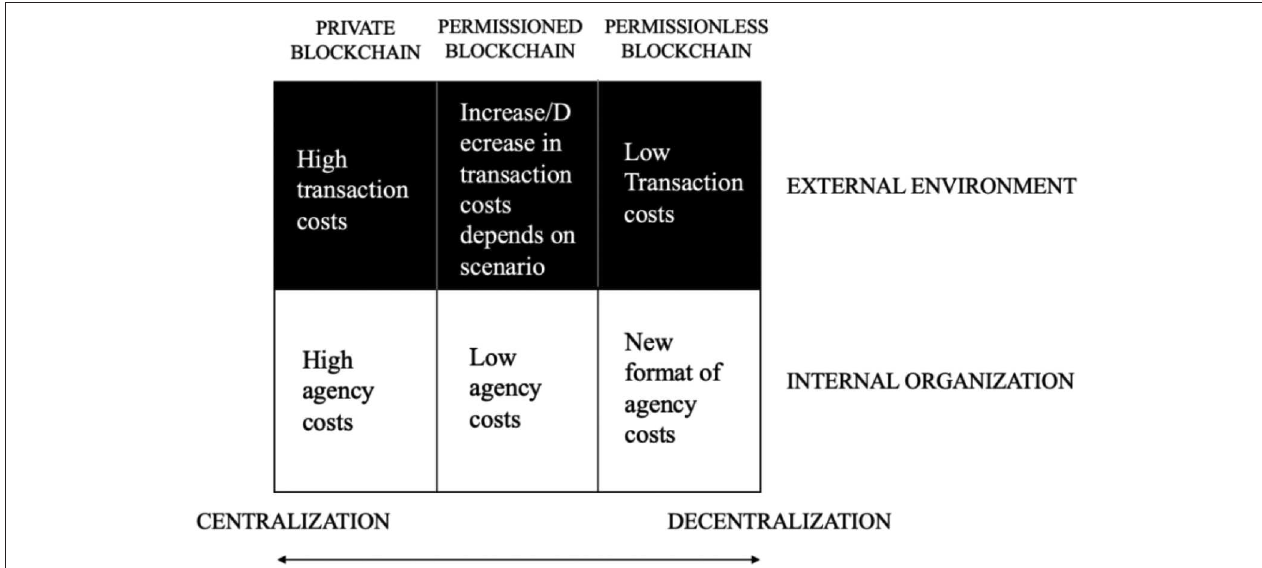
FIGURE 5 | The evolution of costs